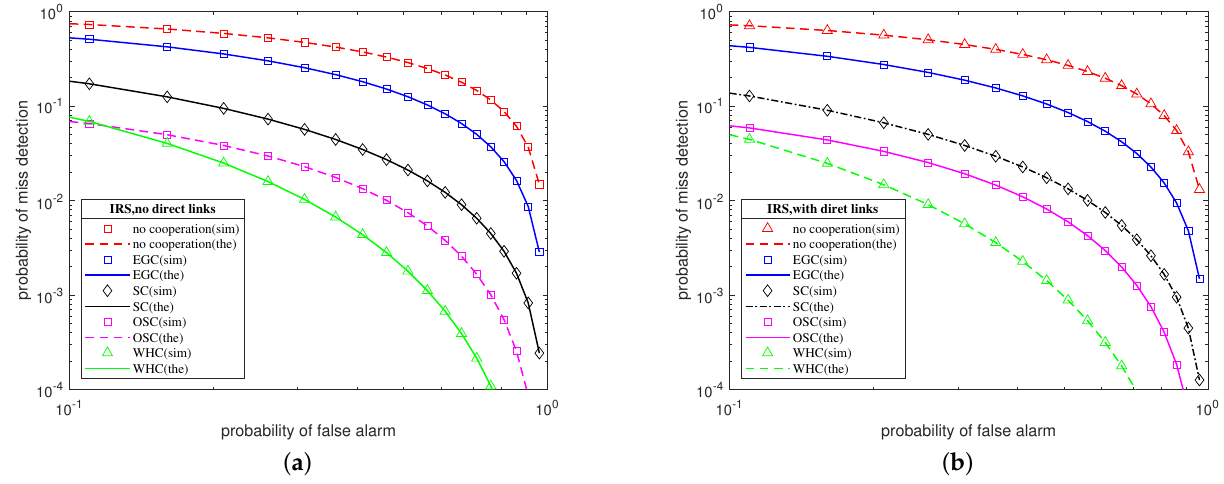
Figure 4. ROC curves for IRS-enhanced CSS and the benchmark scheme without cooperation. ( a ) no direct links; ( b ) with direct